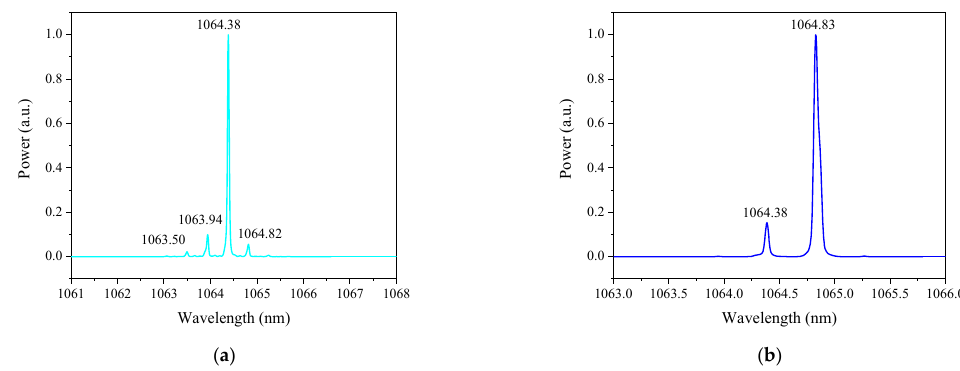
Figure 6. ( a , b ) The power spectrums of the pump source at the maximum power with the pulse width of 2 ns and 4 ns, respectively.